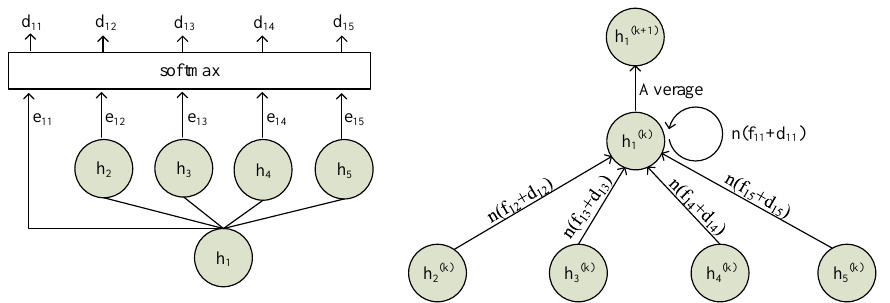
Figure 4. ( Left ): the process of calculating the dynamic attention weights. ( Right ): the information aggregation process. n ( · ) denotes a normalized